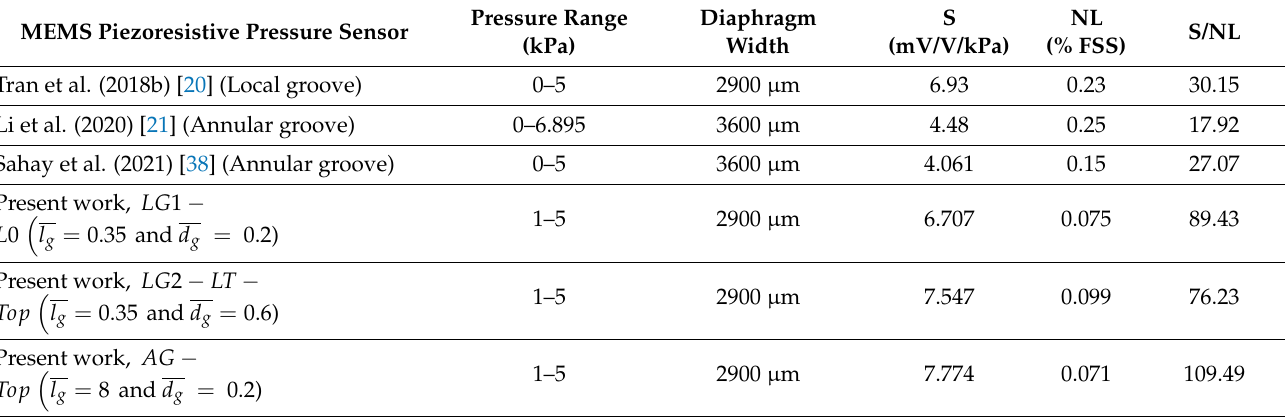
Table 3. Comparison of performance parameters of different MEMS piezoresistive pressure sensors.